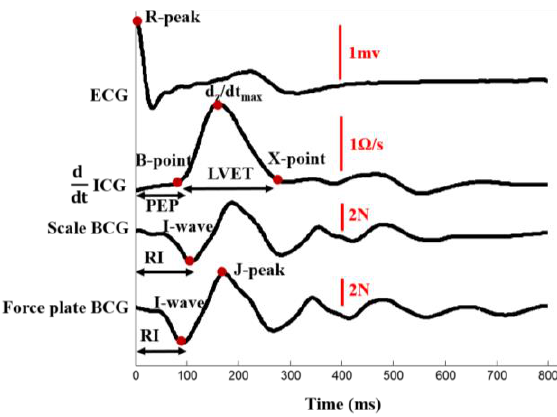
Figure 2. Ensemble averaged traces of ECG, 𝒅 with the characteristic points and features.